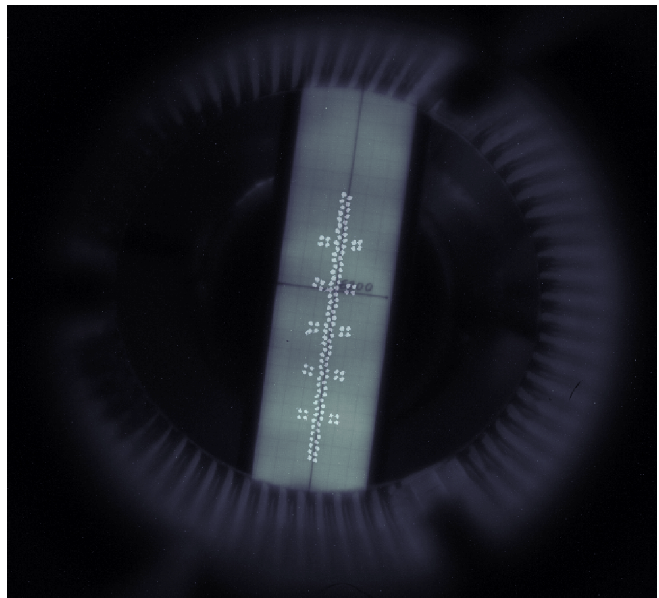
Figure 9. Image of all the fibers on the semi-transparent screen taken by the AEB20 CMOS camera (merged